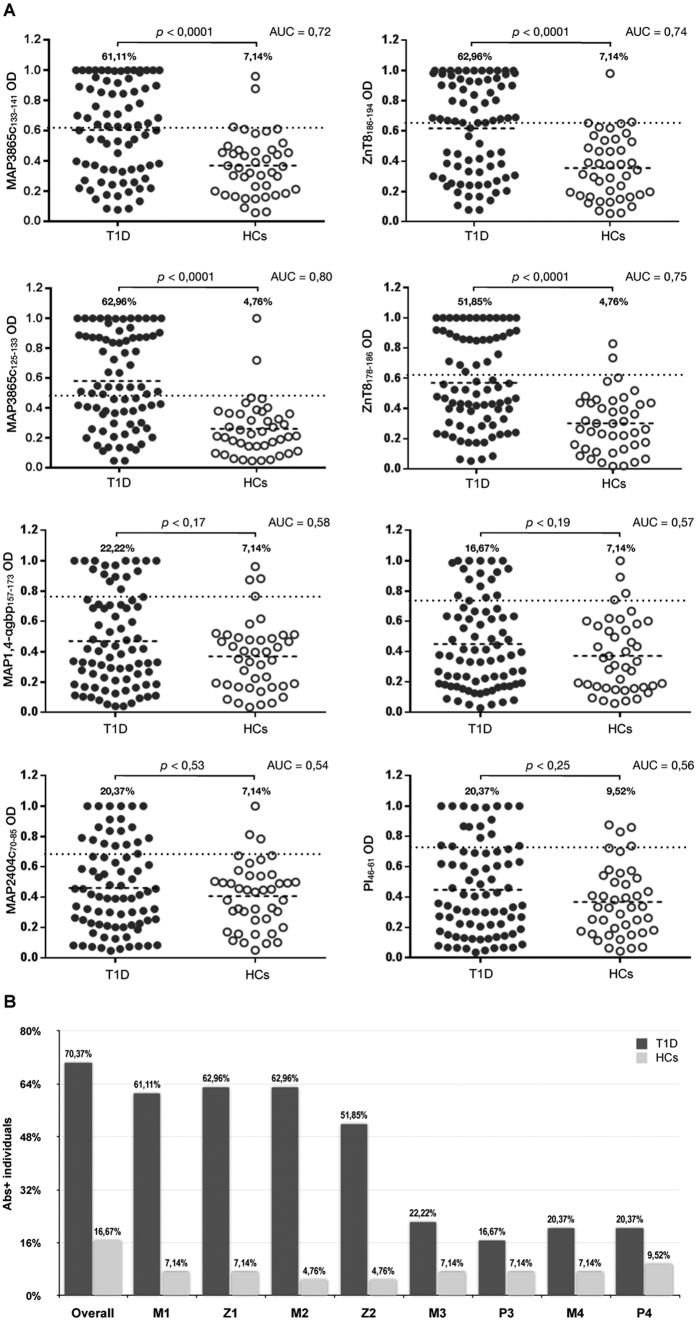
Prevalence of Abs against MAP, proinsulin and ZnT8 homologous epitopes in T1D at-risk subjects and healthy controls.Sera were tested in duplicate for their reactivity against plate-coated peptides: MAP3865c133–141 (M1); ZnT8186–194 (Z1); MAP3865c125–133 (M2); ZnT8178–186 (Z2), MAP1,4αgbp157–173 (M3); PI64–80 (P3); MAP2404c70–85 (M4); PI46–61 (P4). (A) Distribution of Abs values based on the statistical analyses performed for all peptides separately. The dotted lines indicate thresholds of positivity relative to each assay calculated by ROC analysis. The percentage of Abs-positive at-risk subjects is reported on top of each distribution; horizontal bars specific for T1D and HCs groups correspond to means. AUC and p values (CI 95%) are indicated above the graphs. (B) Percentage of children with Abs positivity to selected epitopes upon single-peptide analysis. The first column pair summarizes reactivity to any of the analysed peptides. Dark bars represent subjects at risk for T1D; light grey bars correspond to HCs.